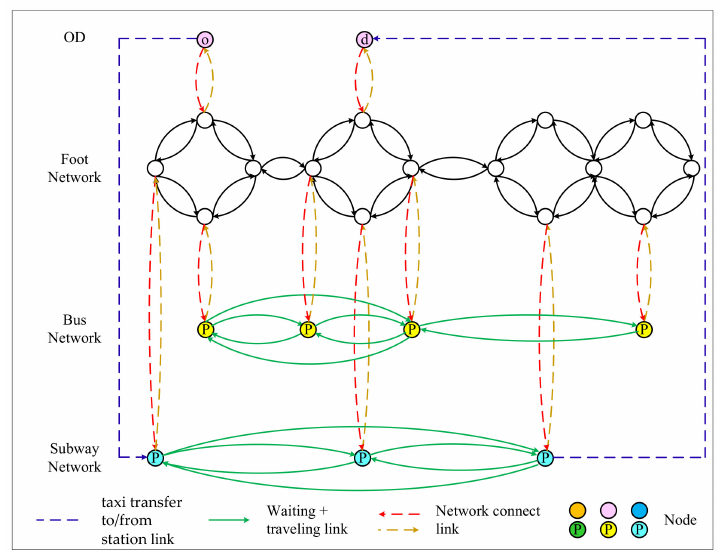
Figure 6. A combined multimodal